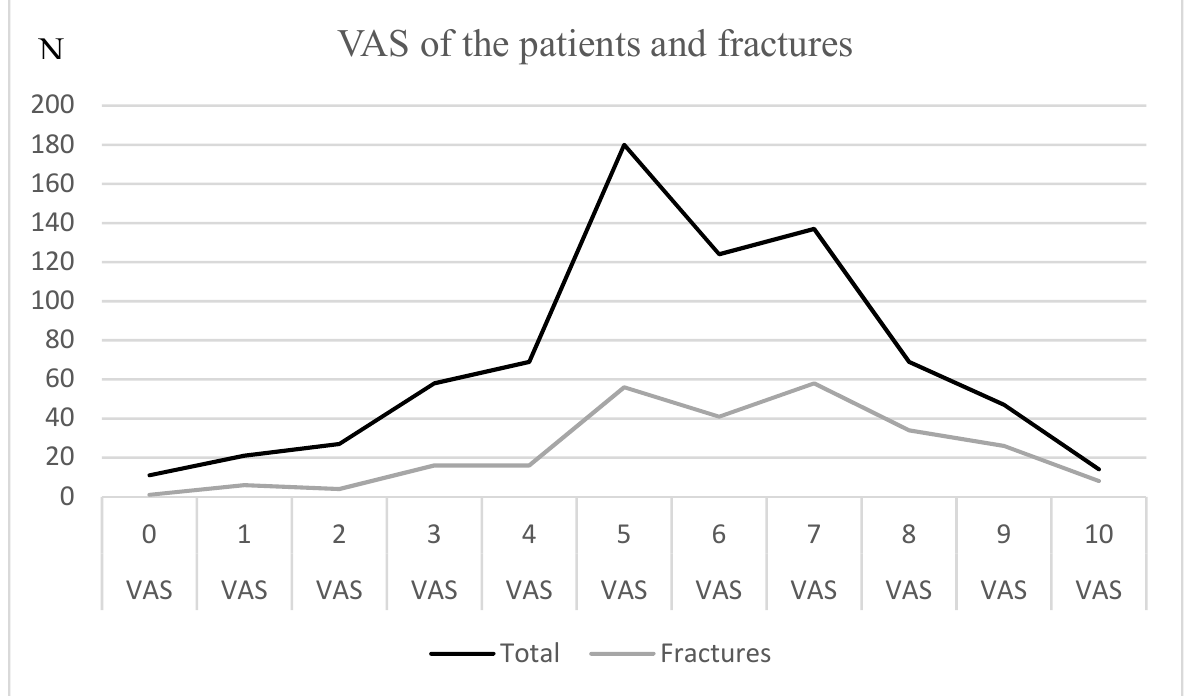
Figure 2. The graph shows the VAS values of all patients (total) and the patients with fractures. For VAS values higher than six, the risk for fracture was higher than 40%, and for a VAS value of 10, the risk was 57.14%. The number of patients with VAS values < 3 and VAS values > 8 was too low to draw a clear conclusion ( n = 11–47).